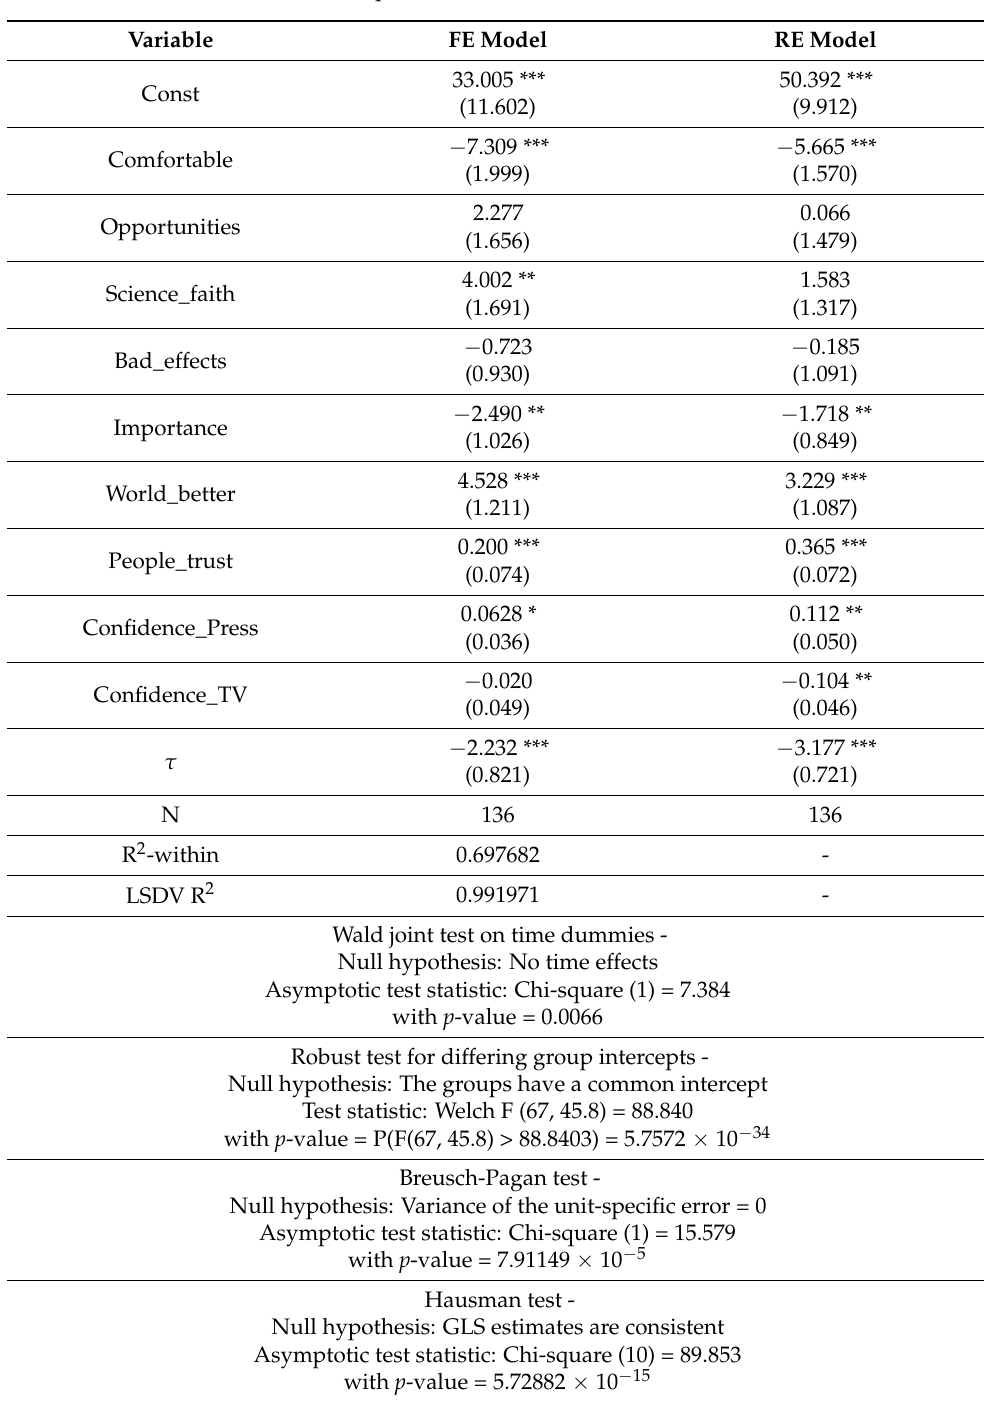
Table 4. Model evaluation results (dependent variable— GII